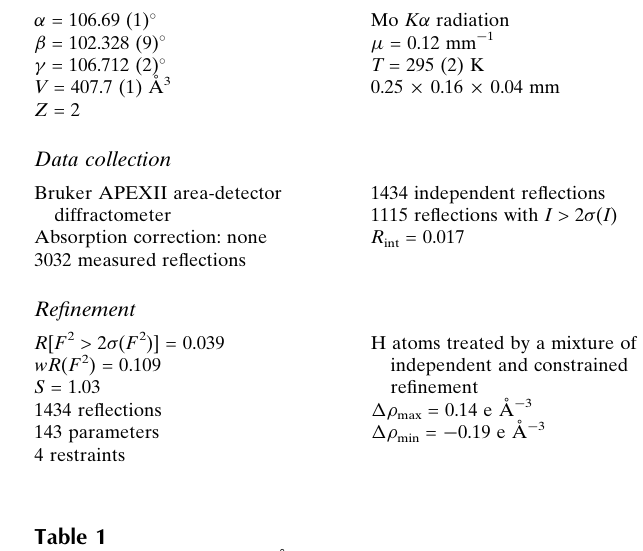
Hydrogen-bond geometry (A˚ , (cid:1)